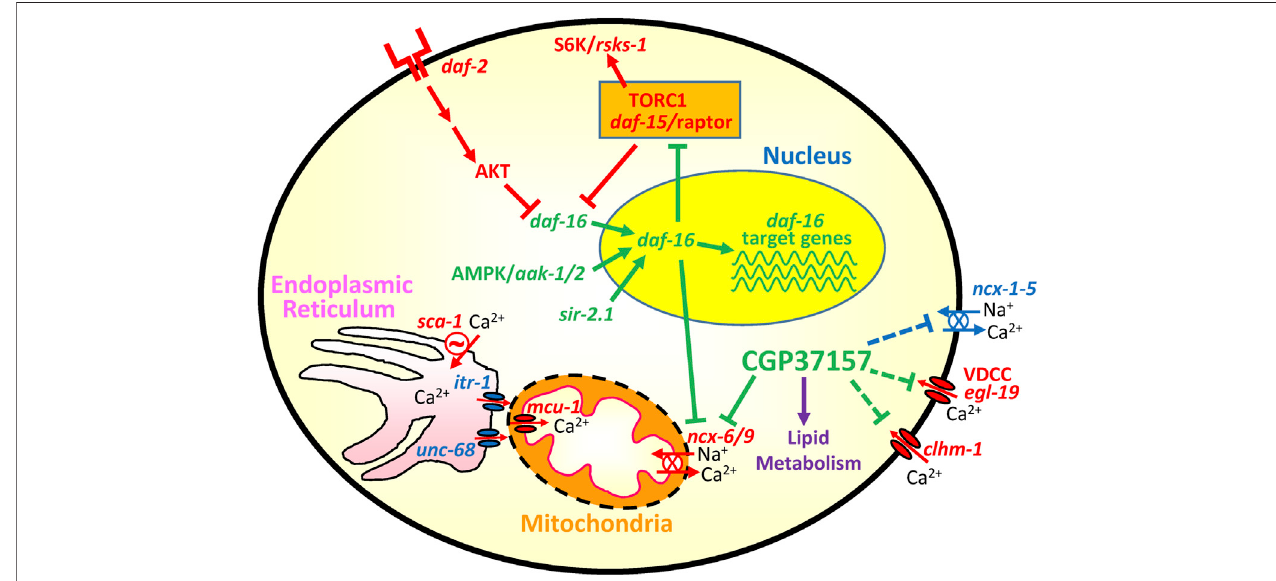
FIGURE9| Cartoonshowingthemainpathways involvedintheeffect ofCGP37157.Activationofthe daf-2 receptorleadstoinactivationof daf-16 bycytoplasmic sequestration.Whenthis pathway isdownregulated, daf-16 enters the nucleus and regulatesaseries oftarget genesthat increase longevity. AMP-activatedkinase and SIR-2.1 promote daf-16 activation, while the TORC1 complex inhibits it. Among the downstream targets of daf-16 we have the TORC1 coactivator daf-15 /Raptor and also the mitochondrial Na + /Ca 2+ exchanger ncx-6. Both are downregulated by daf-16 . CGP37157 also inhibits ncx-6/ncx-9 , and it may also inhibit several Ca 2+ channelsandtransportersintheplasmamembrane.ThecartoonalsoincludestheCa 2+ connectionbetweenendoplasmicreticulumandmitochondria,composedofthe Ca 2+ channels itr-1 (IP 3 receptor) and unc-68 (ryanodine receptor), the ER Ca 2+ pump ( sca-1 ) and the mitochondrial Ca 2+ uniporter ( mcu-1 ). In green, pathways pro- survival. In red, pathways